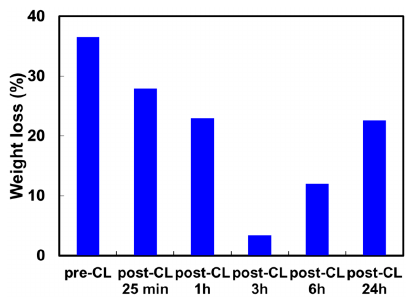
Figure 1. Dissolution of crosslinked quaternized polyvinyl alcohol (CL-QPVA) in 60 °C. The crosslinker was incorporated before (pre-cross-linking (pre-CL)) or after (post-cross-linking (post-CL)) the films were dried. The crosslink times of the post-CL samples are